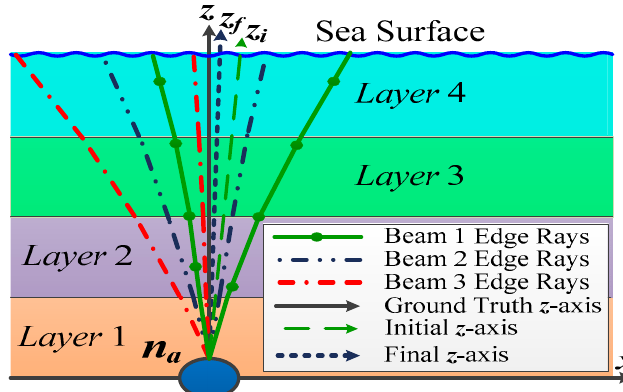
Figure 6. Conceptual 2D representation of the z-axis refinement process where bisecting beam 1 containing the surface reflected ray orients towards z i . Then, by transmitting Beams 2 and 3, and detecting their reflections, the node adjusts the direction of the z-axis to z f that bisects the angle between the furthest edge rays of beams 1 and 2.